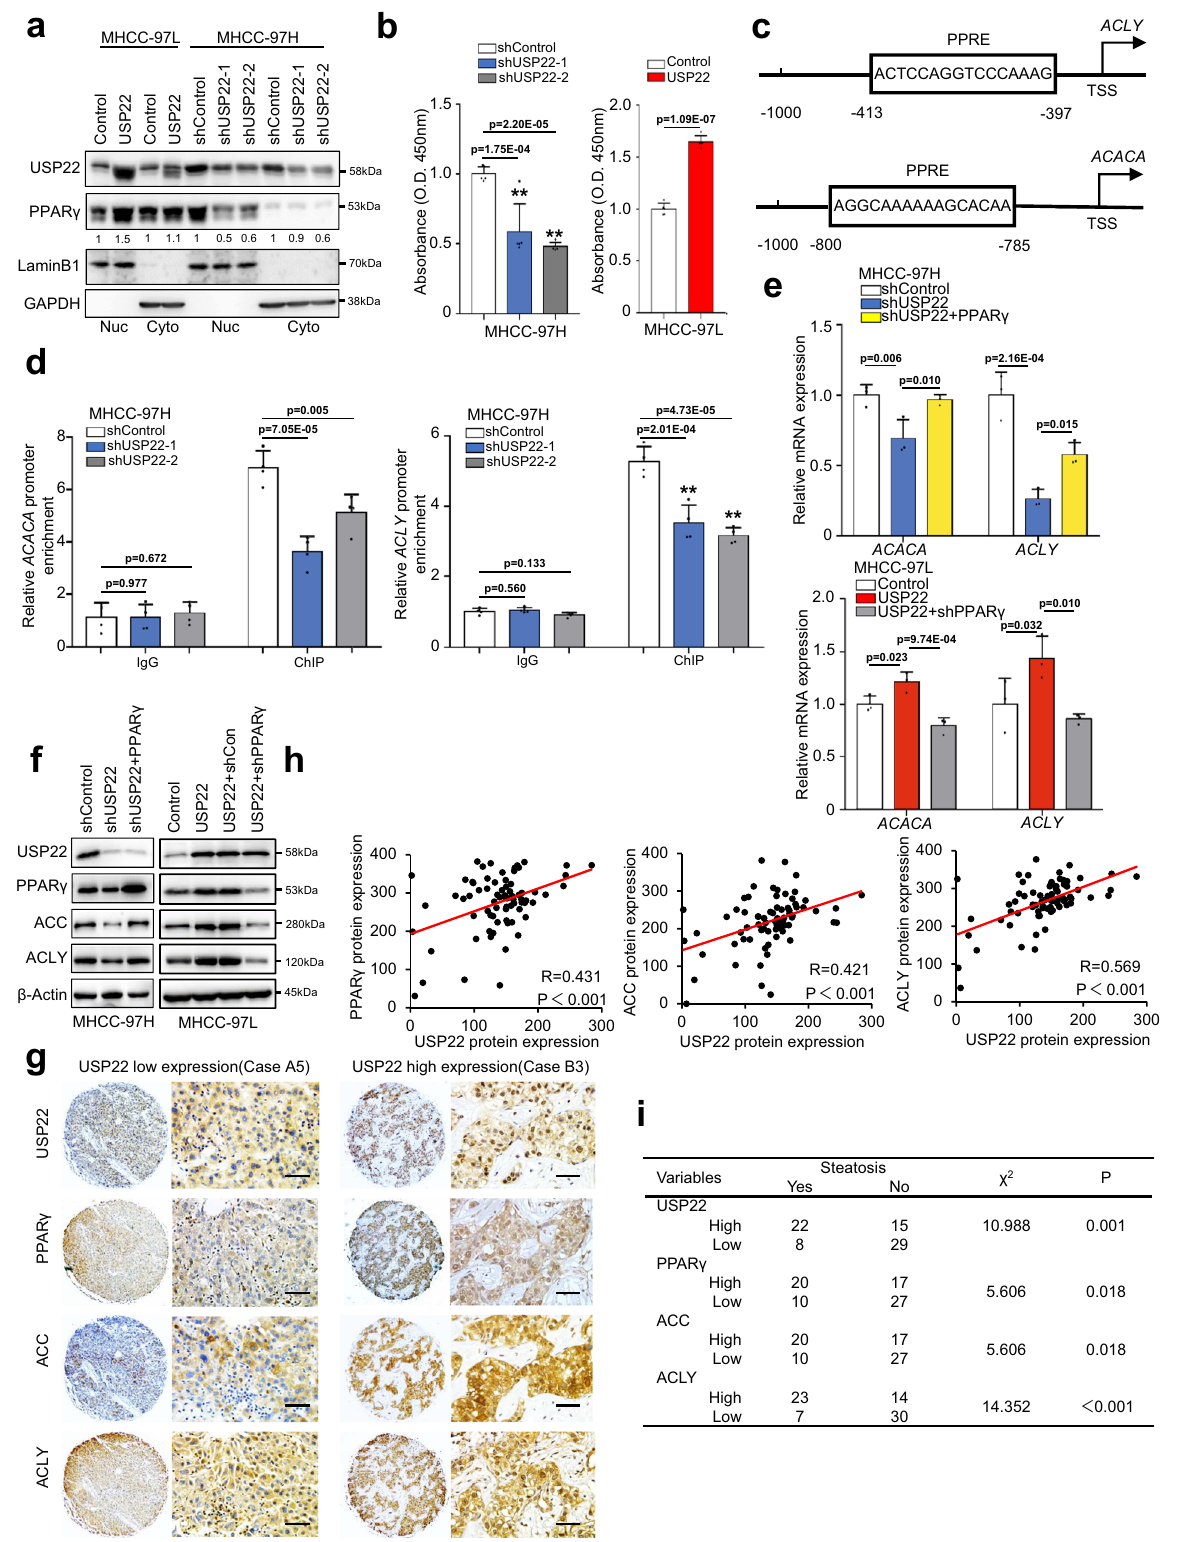
Plasmids . Lentiviral shRNAs were cloned in pLKO.1 within the AgeI/EcoRI sites at the 3 ′ end of the human U6 promoter. The targeted sequences were shown in Supplementary Table 2. All the expression vectors used in this study (including SFB-PPAR γ , Myc- USP22, pLoc-USP22 and Lenti-PPAR γ ) were constructed using Gateway Technology (Invitrogen). Brie fl y, cDNAs with attB homologous sequence were generated by PCR and then subcloned into pDONR221 vector as the entry clones.